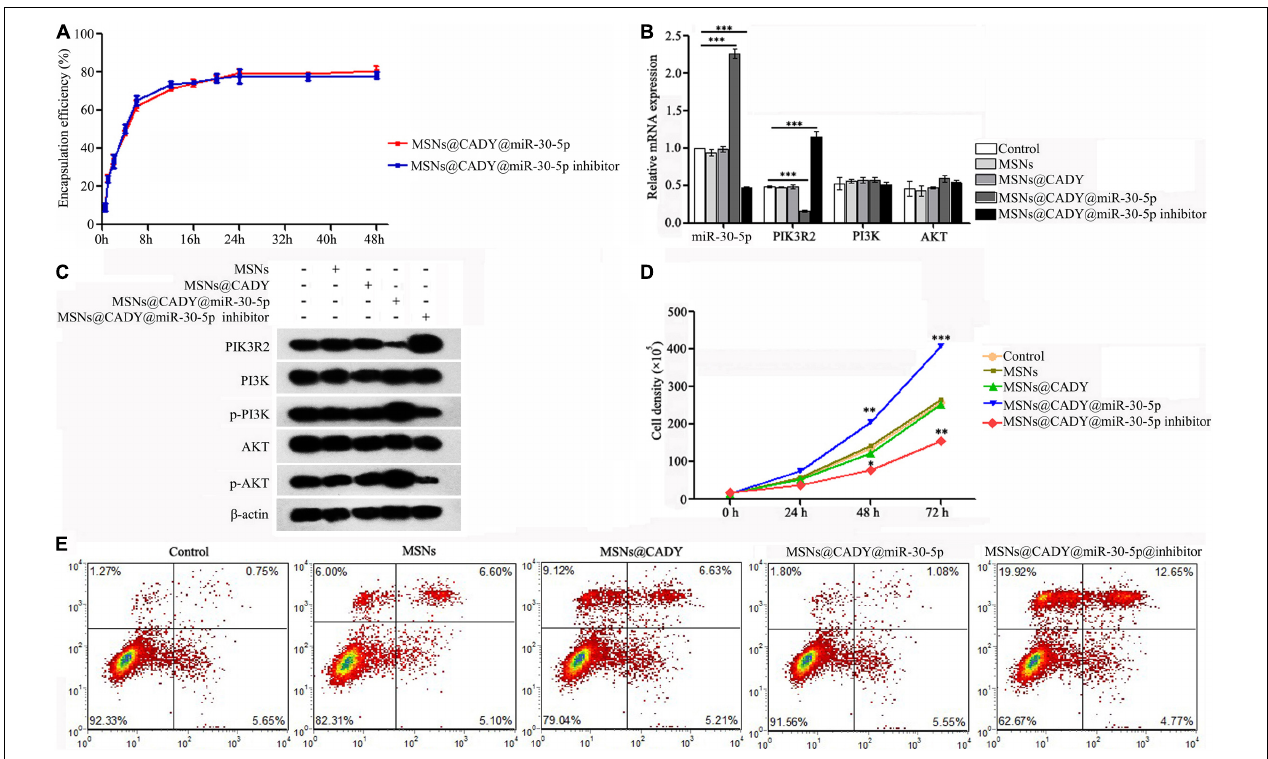
FIGURE 6 | miR-30-5p inhibitor-loaded MSNs@CADY inhibited the proliferation and promoted the apoptosis of RASF cells by targeting PIK3R2. (A) The encapsulation efficiency of MSNs@CADY@miR-30-5p and MSNs@CADY@miR-30-5p inhibitor for miR-30-5p and miR-30-5p inhibitor was determined using semipermeable dialysis bags in PBS (pH 7.4) at 37 ◦ C. RASFs were treated with 100 µ g/ml MSNs, MSNs@CADY, MSNs@CADY@miR-30-5p and MSNs@CADY@miR-30-5p inhibitor for 24 h. (B) Relative mRNA expression of miR-30-5p, PIK3R2, PI3K, and AKT as determined by qPCR. (C) Relative protein expression of PIK3R2, PI3K, p-PI3K, AKT, and p-AKT as determined by Western blot. (D) The cell number was determined after treatment with different nanodrug carriers for 0, 24, 48, and 72 h. The graph represents the cell growth curve for each group. (E) The RASF apoptosis level in each group was measured by Annexin V/PI staining. Experiments were repeated three independent times ( ∗ p < 0.05, ∗∗ p < 0.01, and ∗∗∗ p <